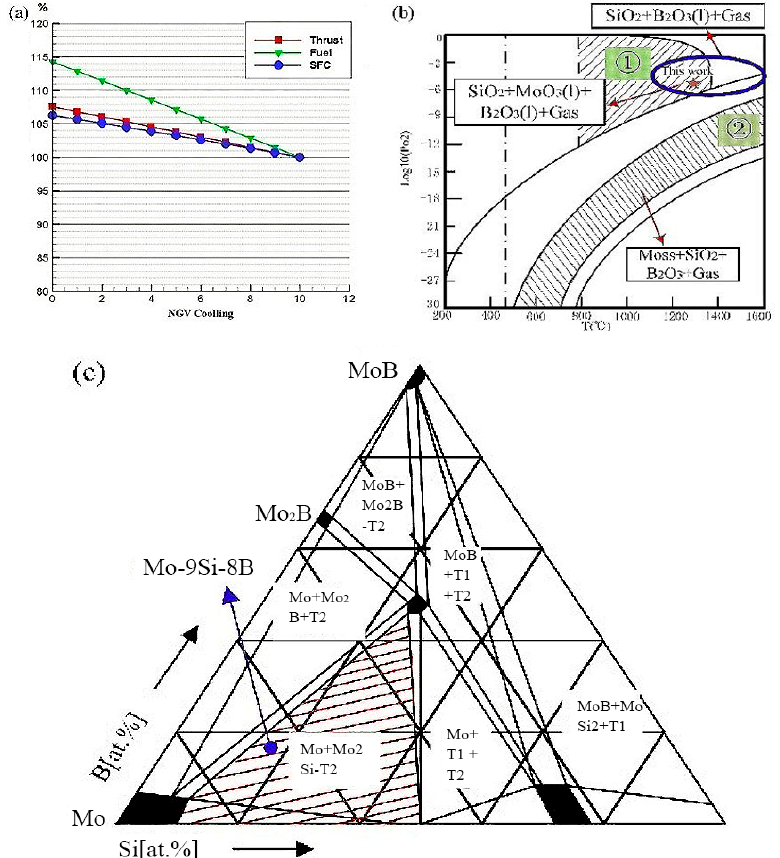
Figure 1. ( a ) Effect of high-conductivity cooling air volume on engine performance in our calculation: Thrust is getting higher with the decrease of the cooling air volume. ( b ) Calculated oxygen partial pressure diagram for the Mo-9Si-8B-O system Adapted from [10]. ( c ) Isothermal section of Mo-Si-B at 1600 ◦ C, the composition chosen for this study was marked Adapted from [11].